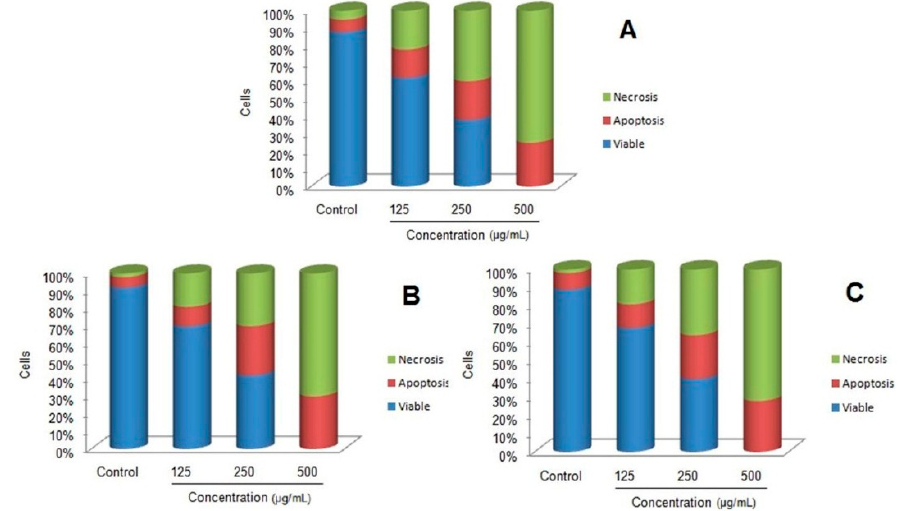
Figure 7. Flow cytometry analysis of untreated and treated 4T1 cells with MnFe 2 O 4 nanoparticles for 24 h ( A ); 48 h ( B ) and 72 h ( C ) stained with annexin V-FITC/propidium iodide (PI).